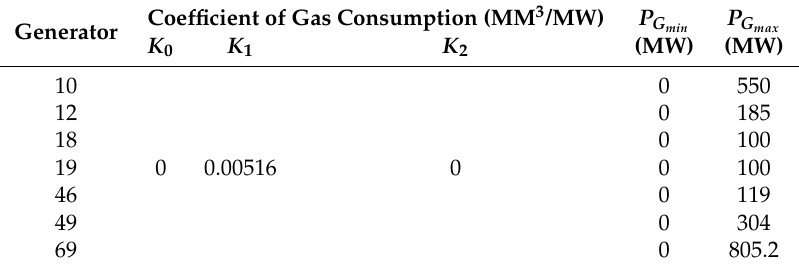
Table A2. Operation characteristics of the combined cycle power plants for Case